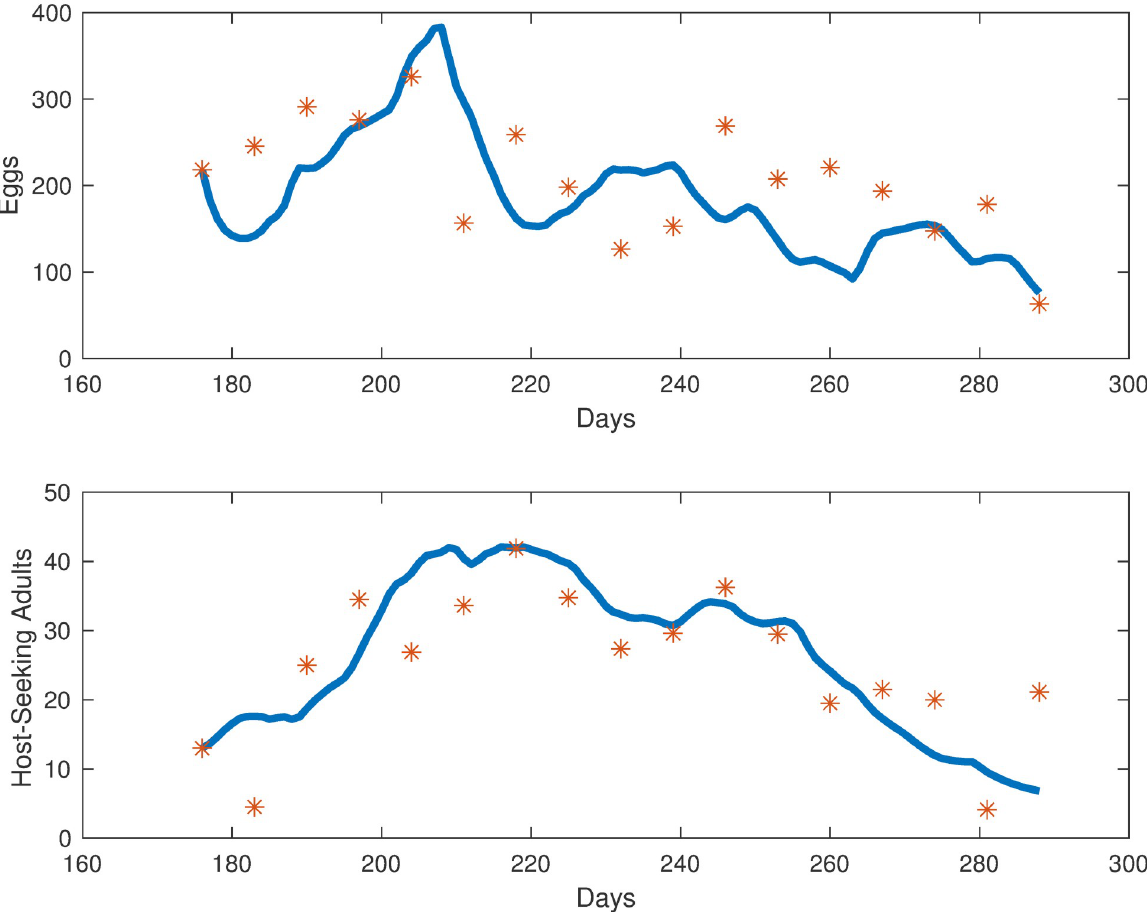
Fig 4. Collected egg and adult mosquito data (represented by red stars) versus egg and adult model simulations (represented by the blue line).